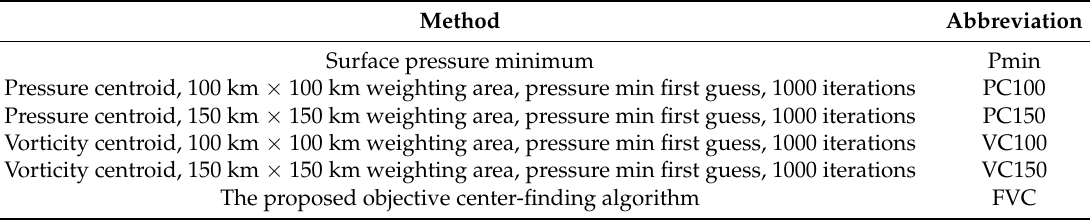
Table 4. Center-finding algorithms used in comparison.